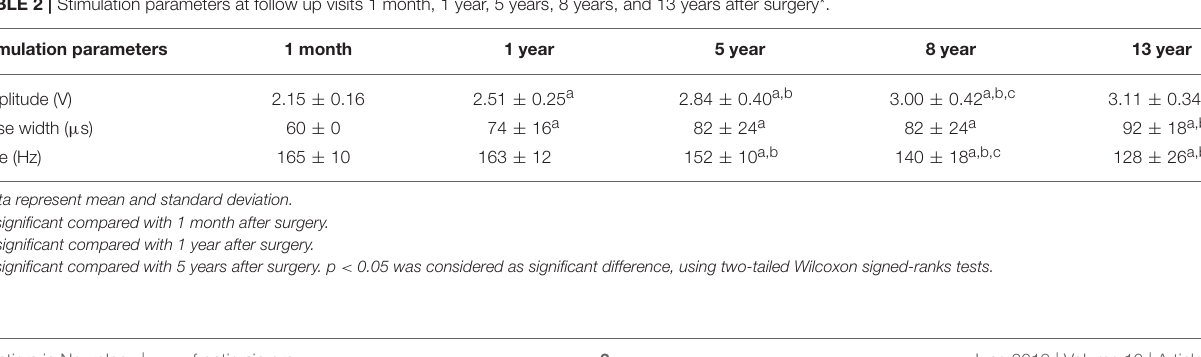
TABLE 2 | Stimulation parameters at follow up visits 1 month, 1 year, 5 years, 8 years, and 13 years after surgery*. Stimulation parameters